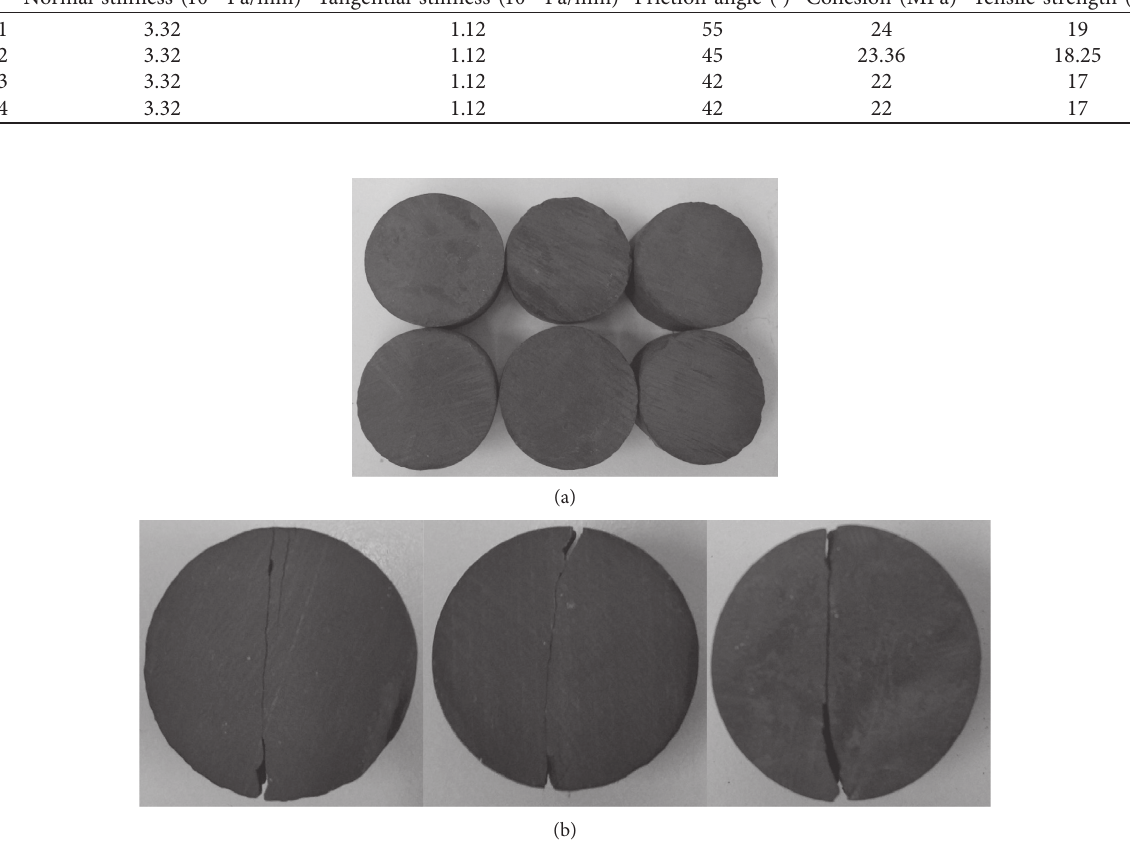
Figure 4: Uniform bedding specimens. (a) Before splitting. (b) After splitting.